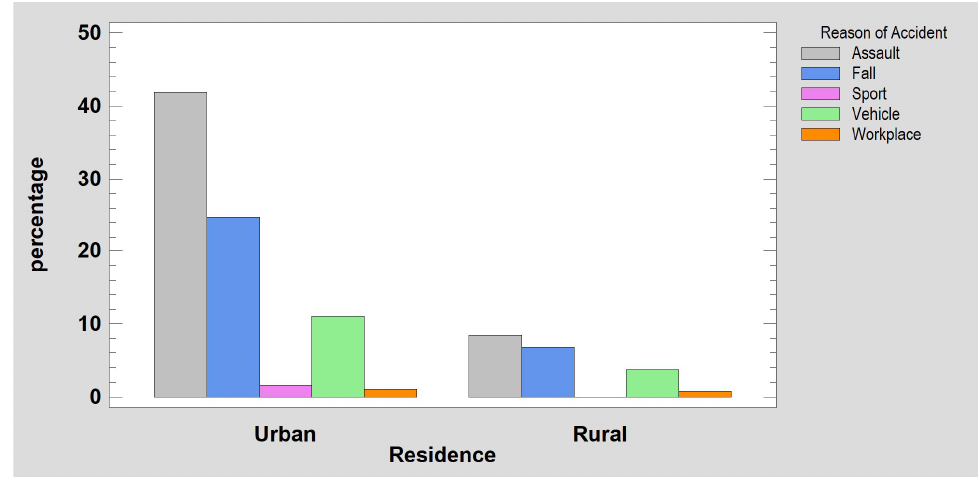
Figure 1. Frequency of observed mandibular fractures in urban and rural populations (no significant differences).